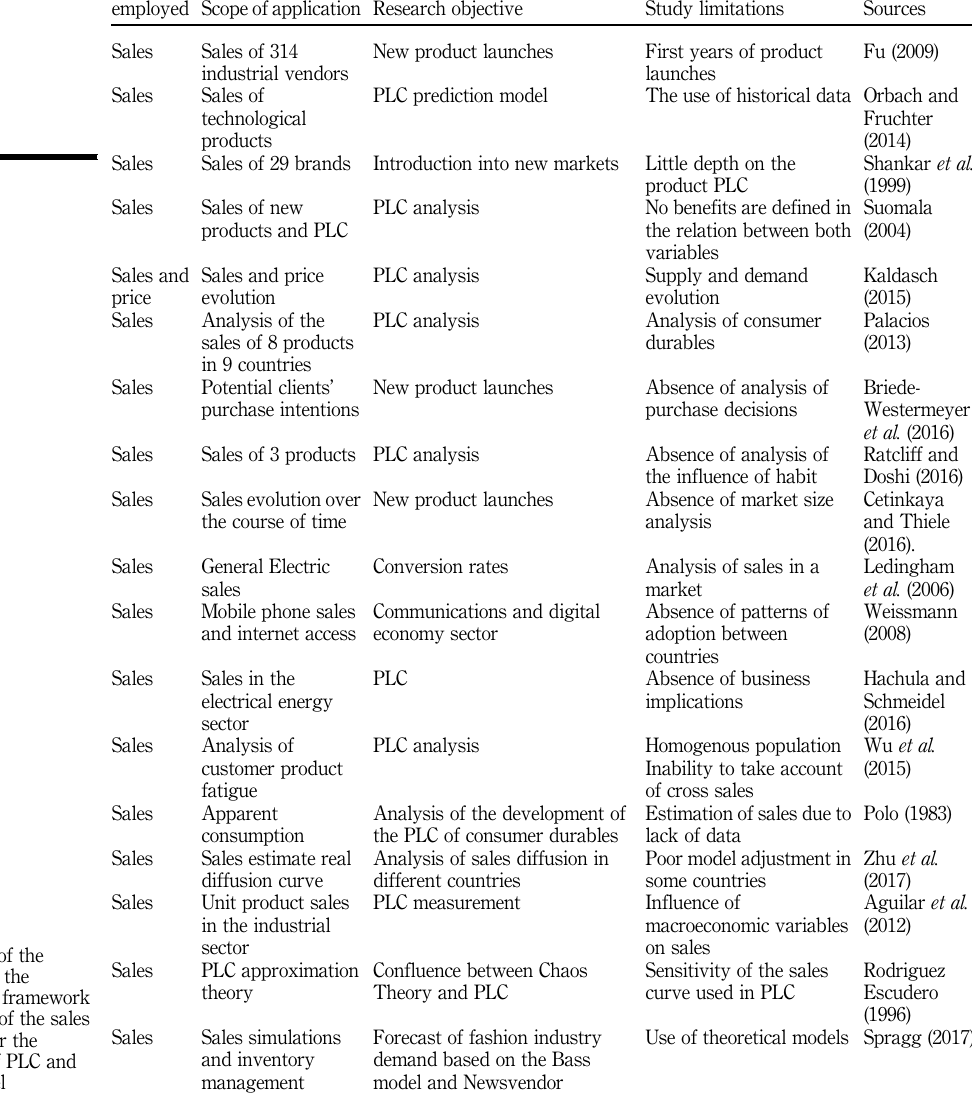
Table I. Summary of the revision of the theoretical framework of the use of the sales variable for the analysis of PLC and Bass